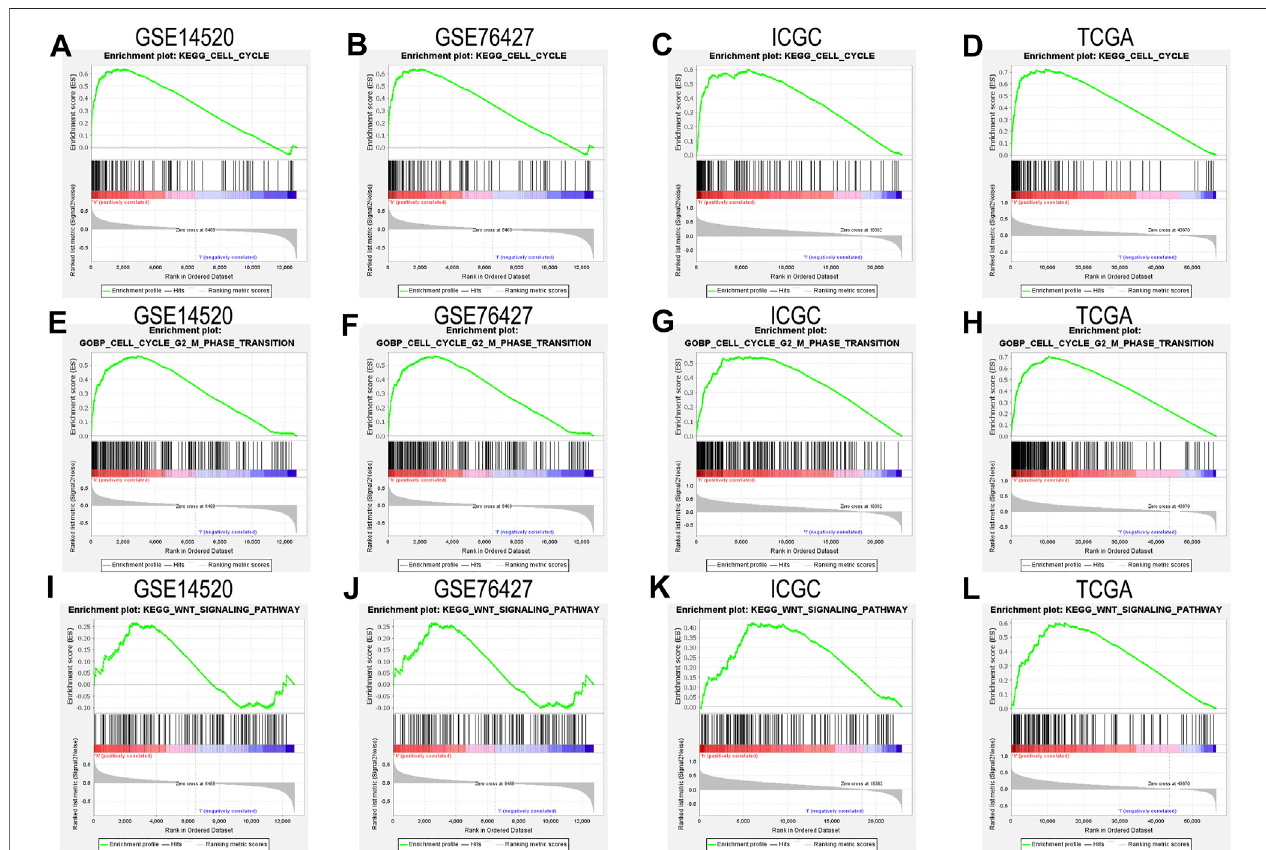
FIGURE5| TheGSEA: (A) theGSEA groundonKEGGintheGSE14520dataset, (B) theGSEAgroundonKEGGintheGSE76427dataset, (C) theGSEAground onKEGGintheICGCdataset, (D) theGSEAgroundonKEGGintheTCGAdataset, (E) theGSEAgroundonGOintheGSE14520dataset, (F) theGSEAgroundonGO in the GSE76427 dataset, (G) the GSEA ground on GO in the ICGC dataset, (H) the GSEA ground on GO in the TCGA dataset, (I) the GSEA ground on KEGG in the GSE14520 dataset, (J) the GSEA ground on KEGG in the GSE76427 dataset, (K) the GSEA ground on KEGG in the ICGC dataset, and (L) the GSEA ground on KEGG in the TCGA